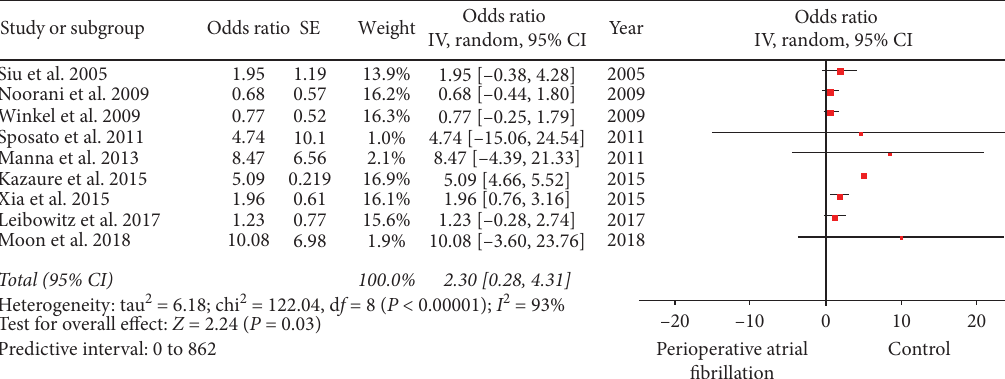
Figure 6: Forest plot evaluating cardiac disease as a risk factor for perioperative atrial fibrillation in patients undergoing noncardiothoracic surgery. The odds ratio of each included study is plotted. A pooled estimate of overall odds ratio (diamonds) and 95% confidence intervals (width of diamonds) summarizes the effect size using the random effects model. CI � confidence interval; M–H � Mantel–Haenszel; OR � odds ratio; I 2 : heterogeneity; P < 0 . 05 is significant.